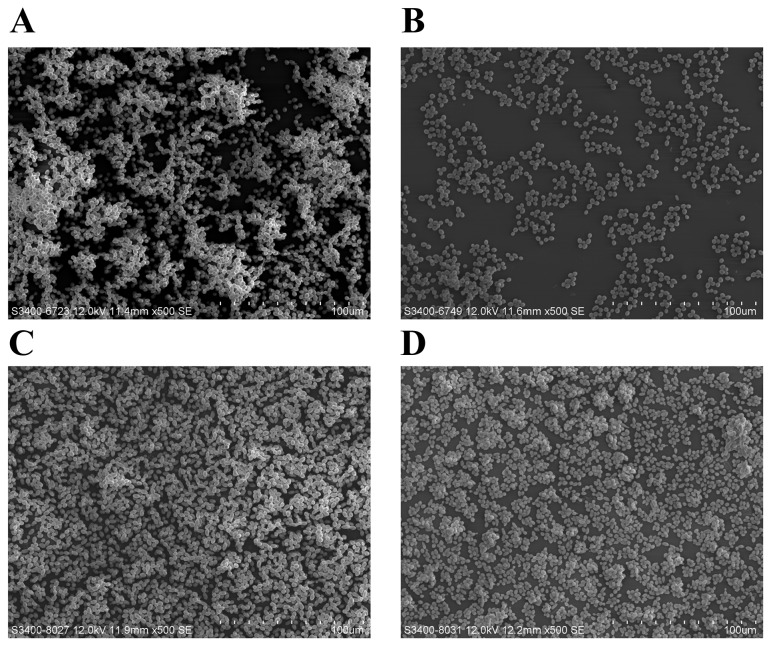
Scanning electron microscopy images of Candida dubliniensis biofilms.Representative SEM images showing the topography of C. dubliniensis biofilms. Fungal biofilms were formed on plastic coverslips, processed, and coated with gold before viewing (magnification 500×). A) Biofilm formation in the absence of purpurin. B) Biofilm formation in the presence of purpurin (1 µg/ml). C) Pre-formed biofilms in the absence of purpurin. D) Pre-formed biofilms in the presence of purpurin (1 µg/ml).